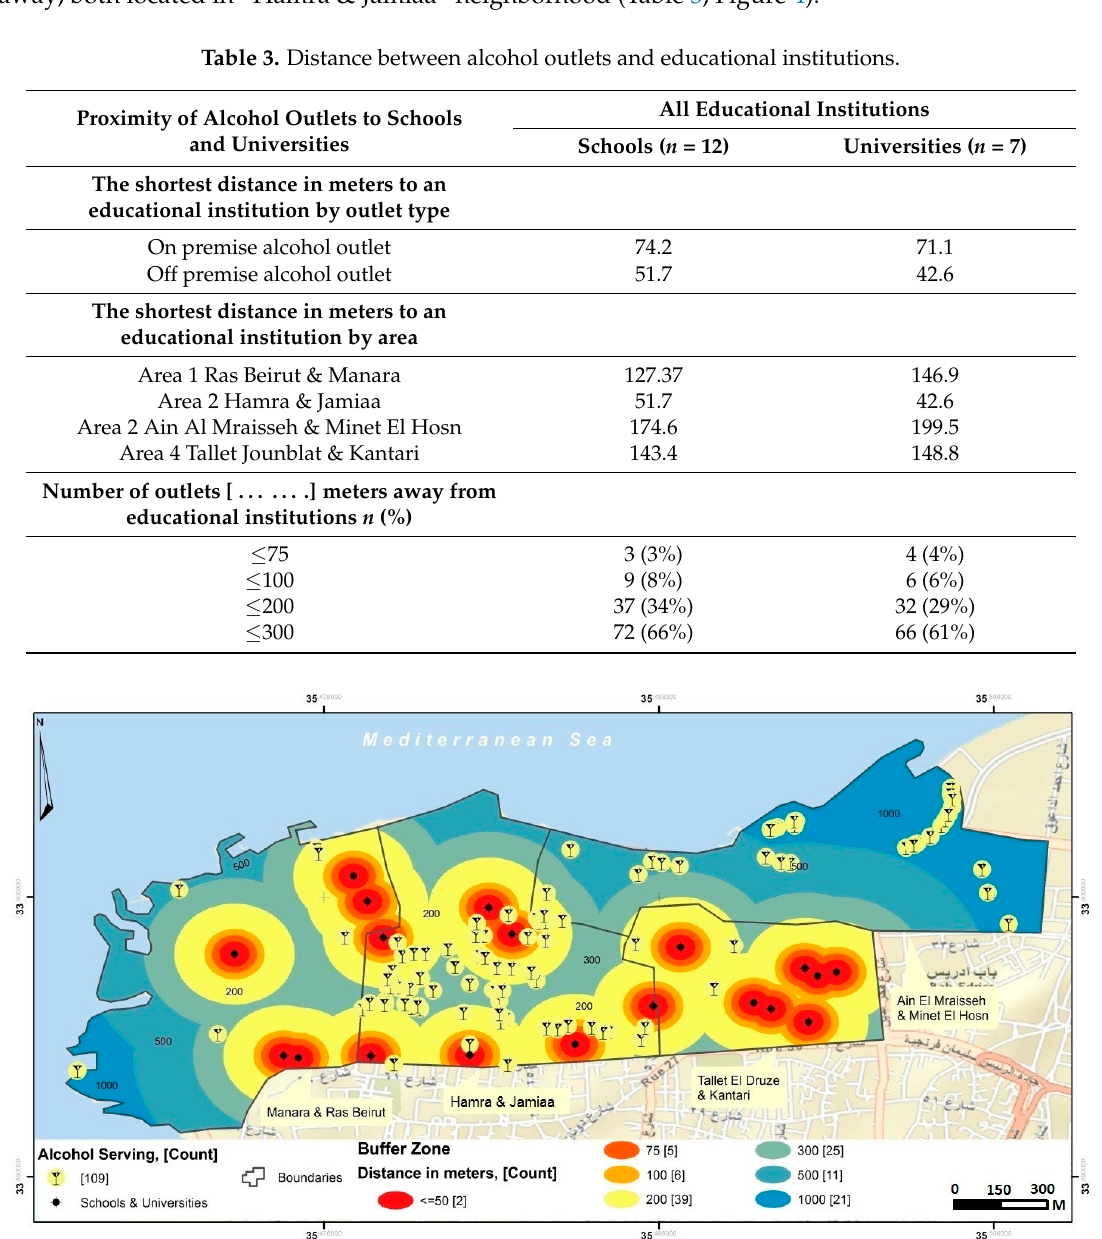
Figure 4. Distance from schools and universities to alcohol outlets.